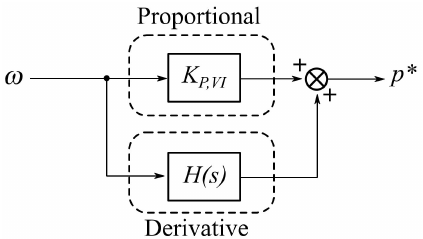
Figure 6. Block diagram showing the VI